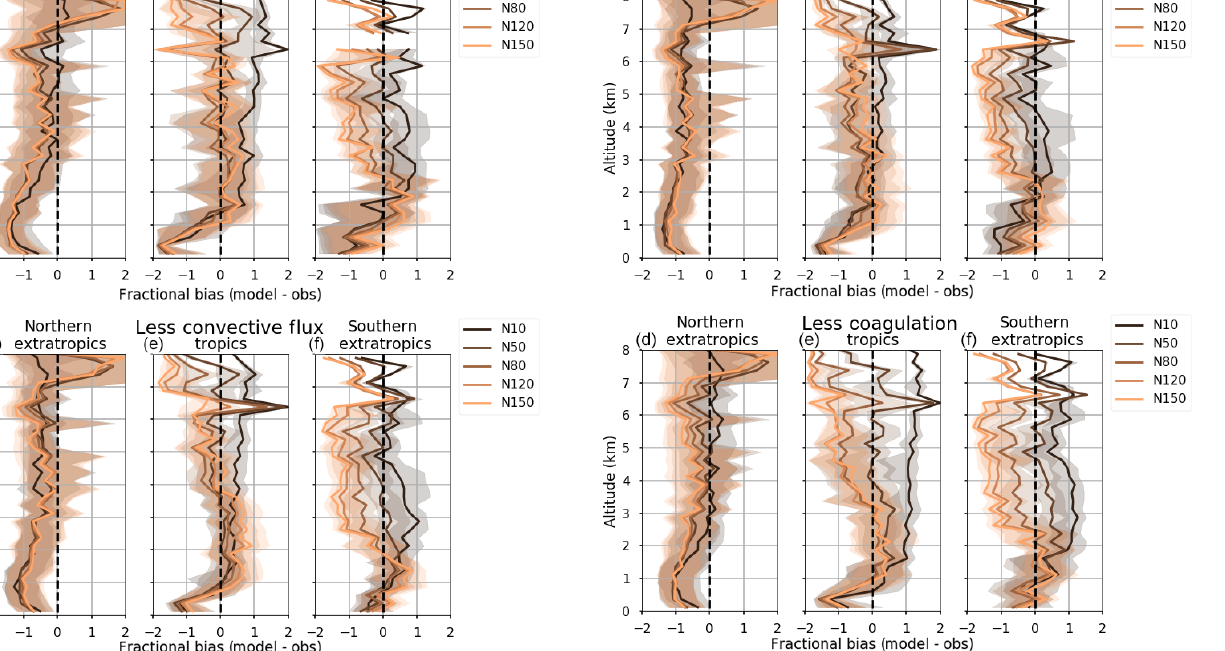
Figure 9. The vertical profile of fractional bias in modelled aerosol number at different size cut-offs for measurements in the northern extratropics (a) , the tropics (b) and the southern extratropics (c) with increased (by a factor of 10) and decreased (by a factor of 0.1) convective tracer entrainment rates.